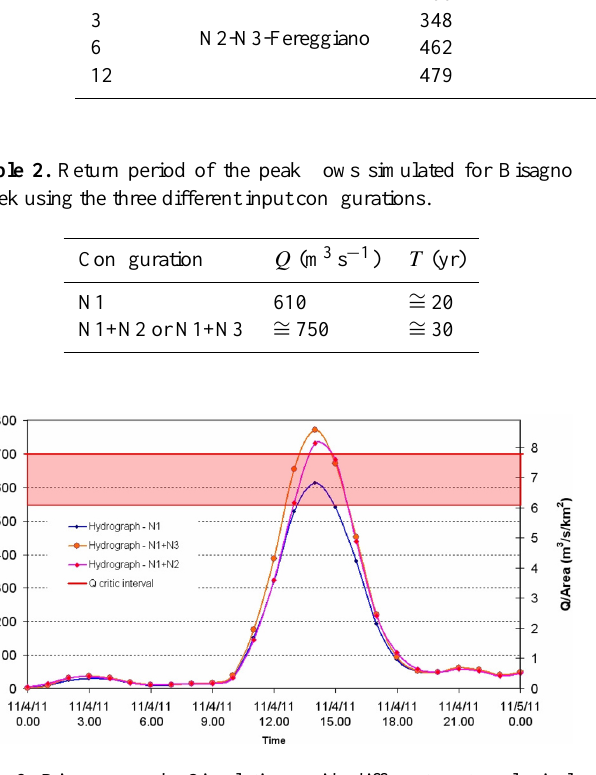
Fig. 9. Bisagno creek. Simulations with different meteorological networks. Q critic is the maximum streamflow that can flow under the cover. On the left y-axis the streamflow is reported while on the right y-axis the flow contribution per unit area is shown. On x-axis the UTC time is reported.